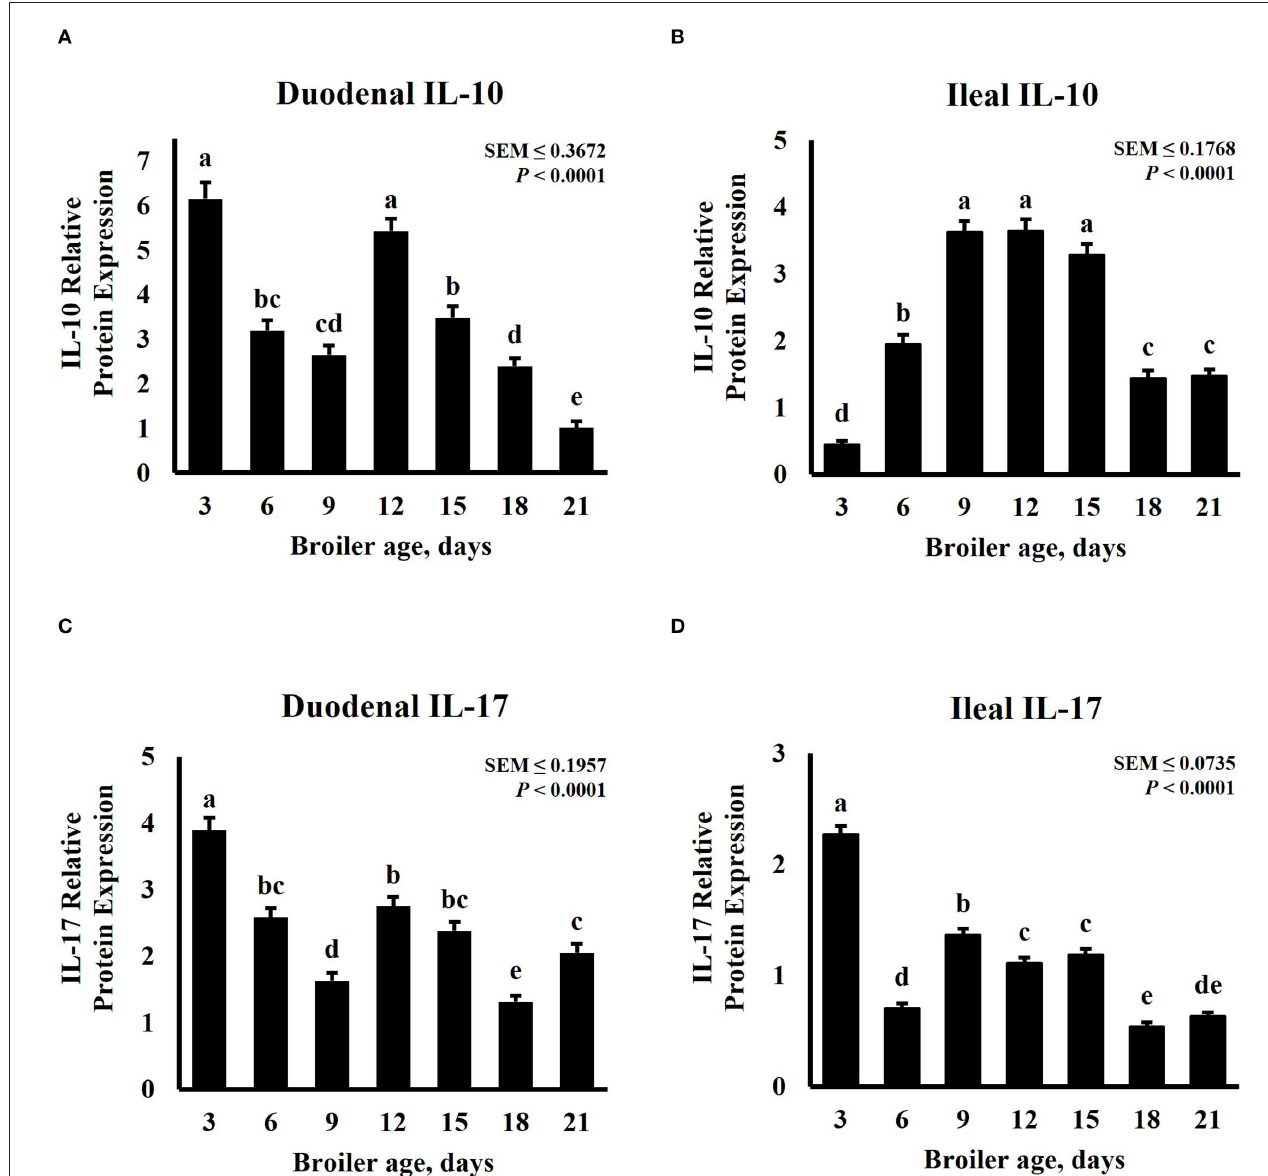
FIGURE 3 | Effect of bird age on intestinal cytokine protein abundance. On each sampling day, a total of 24 birds (n = 12 birds of each treatment from 12 blocks) were selected for tissue collection. Protein expression was measured using quantitative, fluorescent Western Blot relative to total protein. (A) Duodenal IL-10 abundance. (B) Duodenal IL-17 abundance. (C) Ileal IL-10 abundance. (D) Ileal IL-17 abundance. a − e Bars with different superscripts differ at P ≤